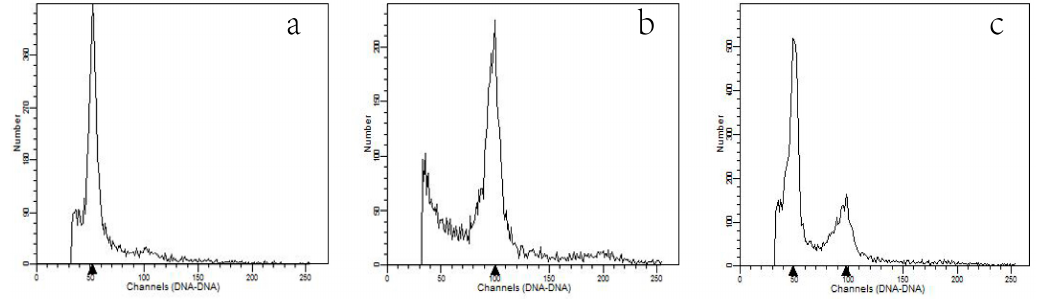
Figure 2. Histograms of flow cytometric analysis of Liquidambar styraciflua × Liquidambar formosana ( a ) diploid plant (control); ( b ) tetraploid plant; ( c ) diploid + tetraploid plant.